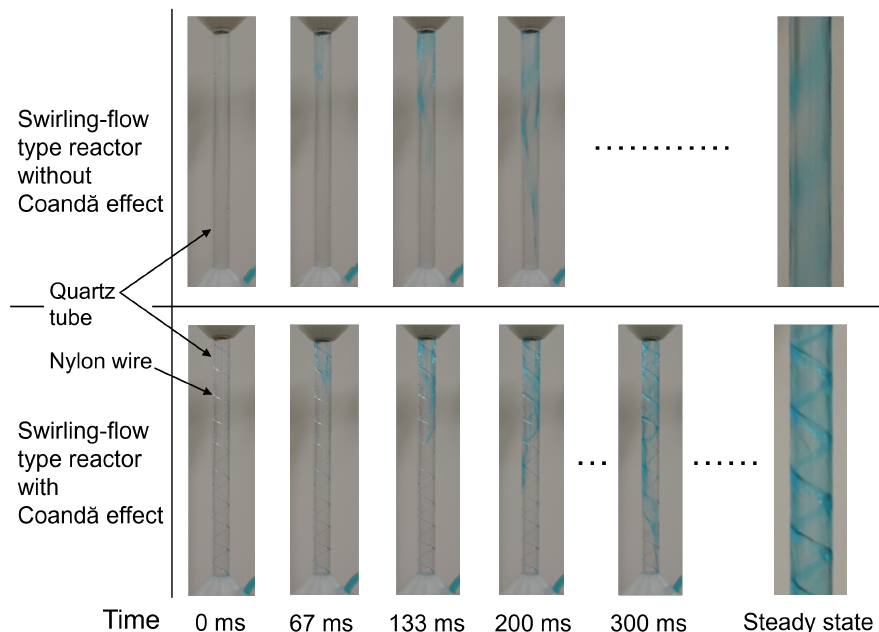
Figure 2. Liquid flow propagating along the inner wall of the quartz tube in the swirling-flow-type reactor without and with the Coand˘a effect. In the latter case, a spirally arranged nylon wire was used to make the swirling liquid flow based on the Coand˘a effect, and the number of turns was 10. The indigo carmine solution was circulated with a flow rate of 1400 mL/min, and its flow was captured by using a digital camera with a frame rate of 60